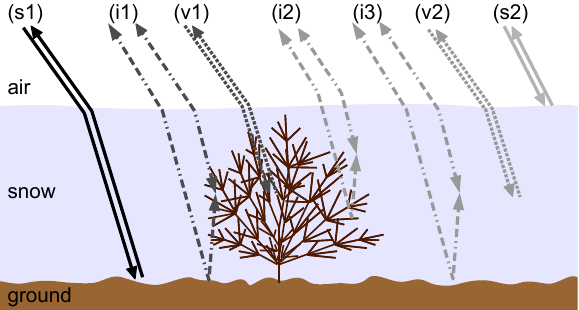
Figure 3. Representation of the scattering mechanisms found in the sub-Arctic environment: (s1) and (s2) represent surface scattering from the ground and snow surface, respectively; (v1) and (v2) represent volume scattering from the vegetation and snow, respectively; (i1), (i2) and (i3) represent the various interaction terms between ground and vegetation, vegetation and snow and ground and snow, respectively.